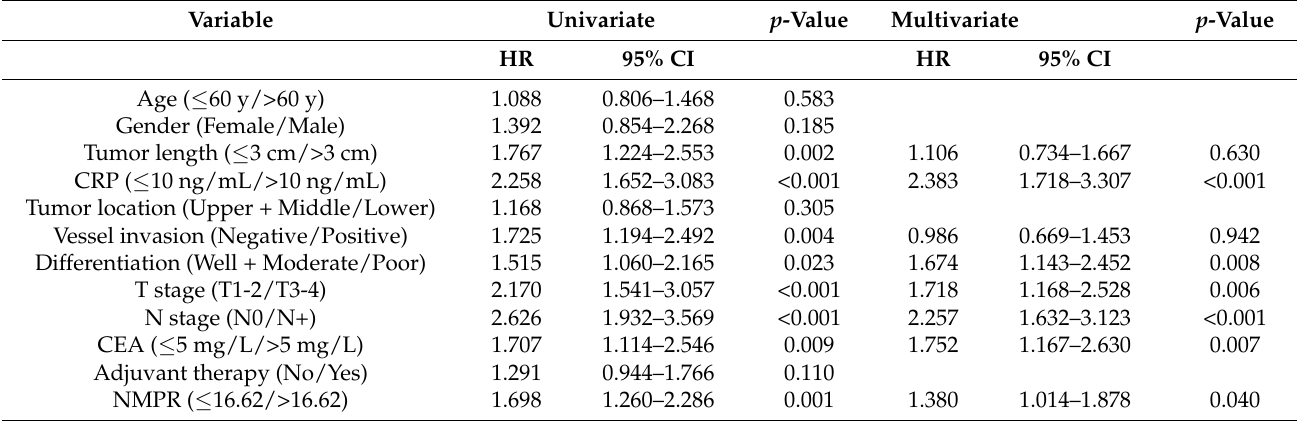
Table 2. Univariate and multivariate Cox regression analyses for overall survival in the training cohort (ZJ